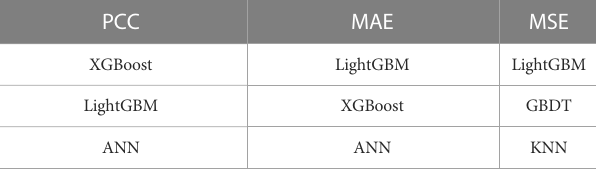
PCC, Pearson ’ s correlation coef fi cient; MAE, mean absolute error; MSE, mean squared error; XGBoost, extreme gradient boosting; LightGBM, light gradient boosting machine; GBDT, gradient boosting decision tree; ANN, arti fi cial neural